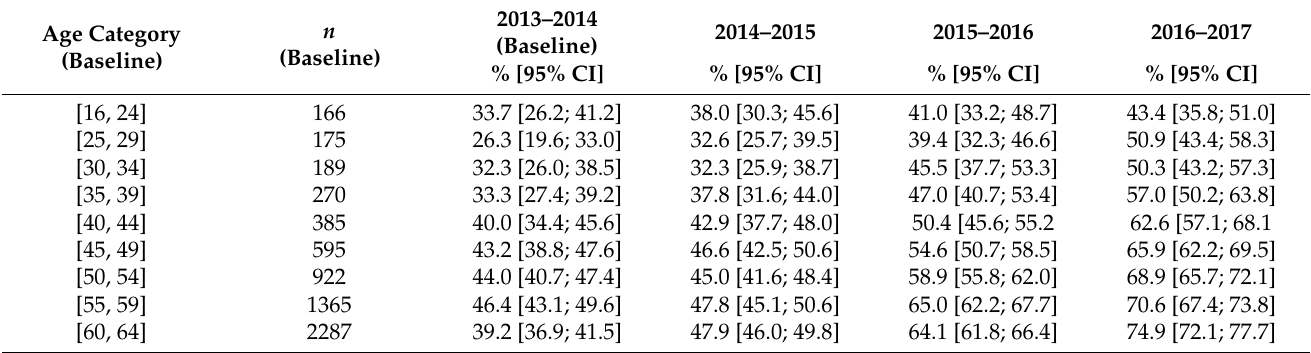
Table 7. Influenza vaccination uptake by age at baseline < 65 group (with chronic